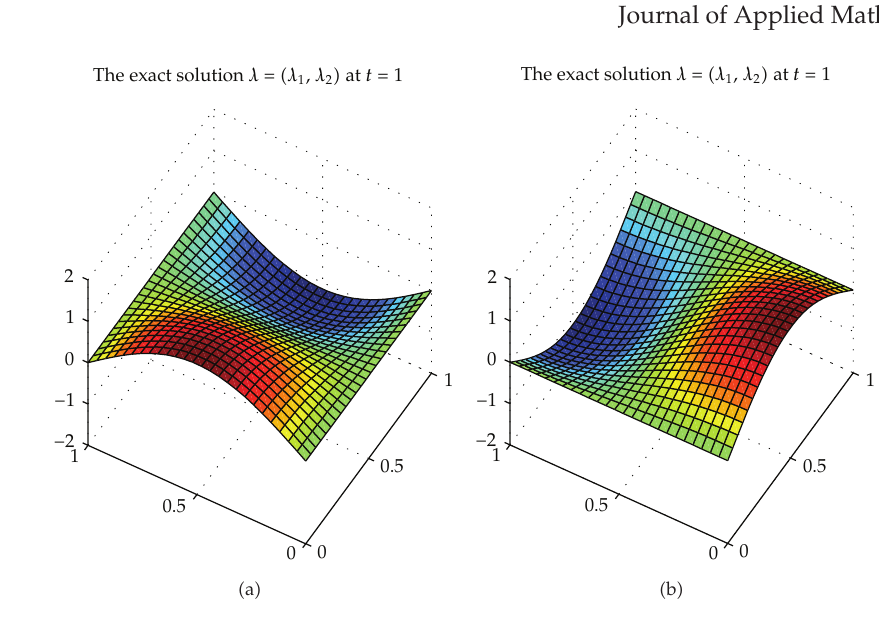
Figure 3: The exact gradient λ 1 (cid:3) a (cid:4) and λ 2 (cid:3) b (cid:4) .